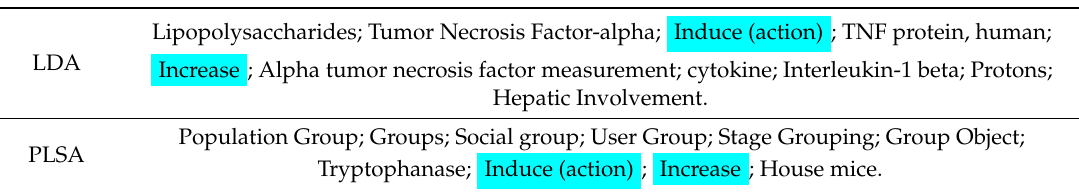
Table 15. The top-1 topic on the tumor-promoting inflammation (TPI)